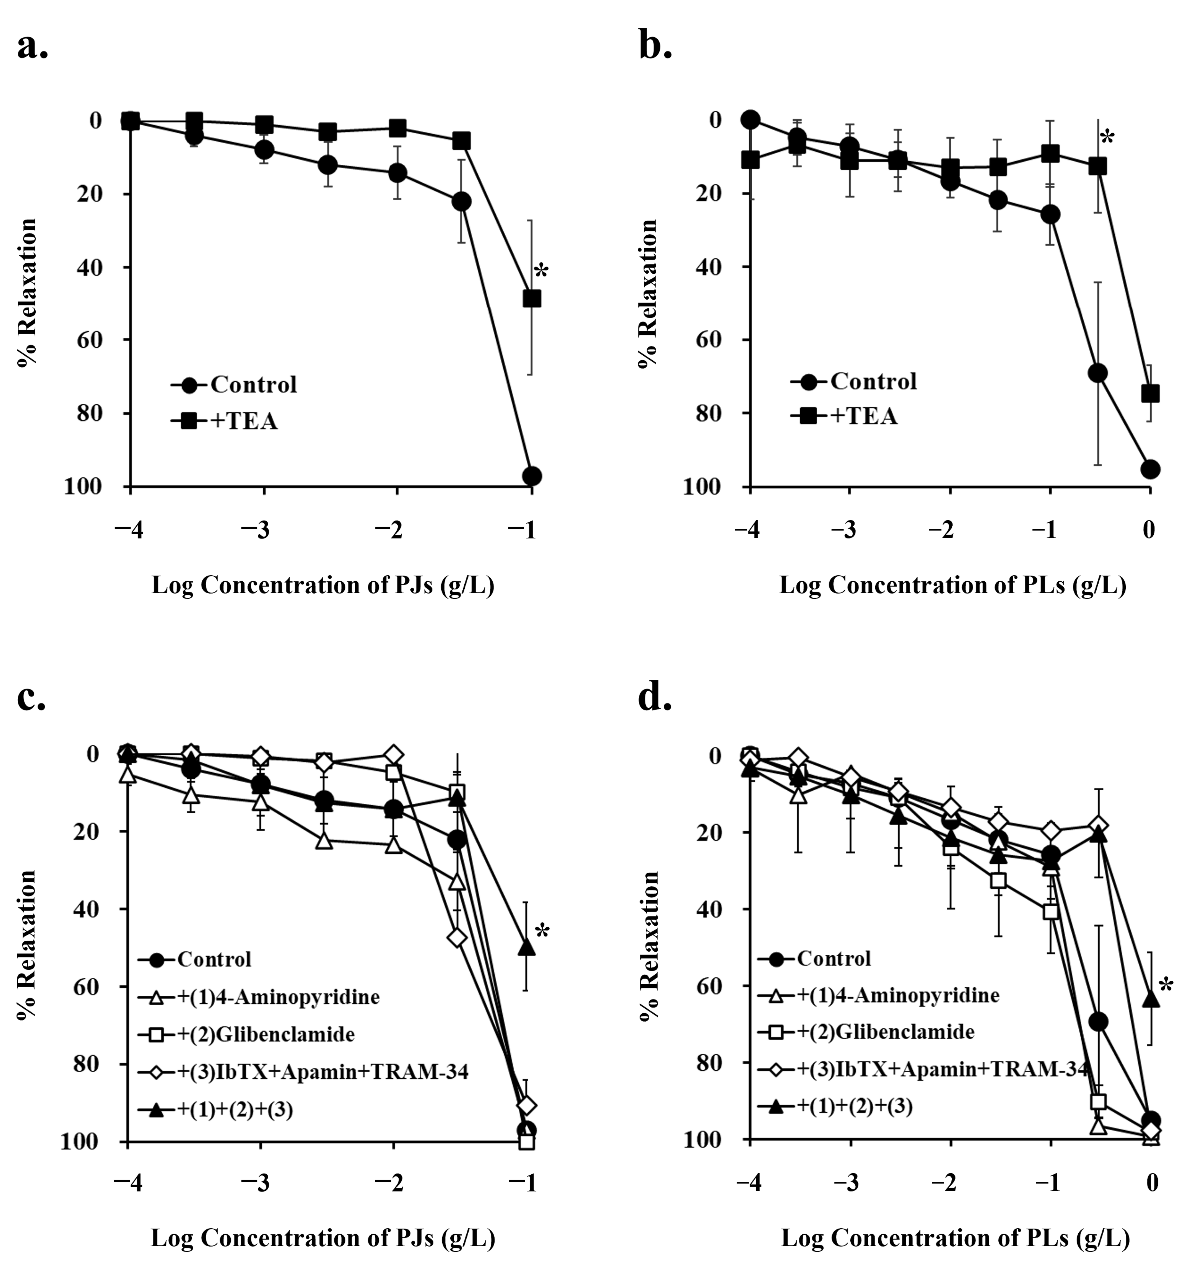
Figure 3. Concentration–response curves for ( a , c ) persimmon juice (PJ)- and ( b , d ) persimmon leaf (PLs)-induced vasorelaxation in endothelium-removed rat superior mesenteric artery rings ( n = 4– 6).